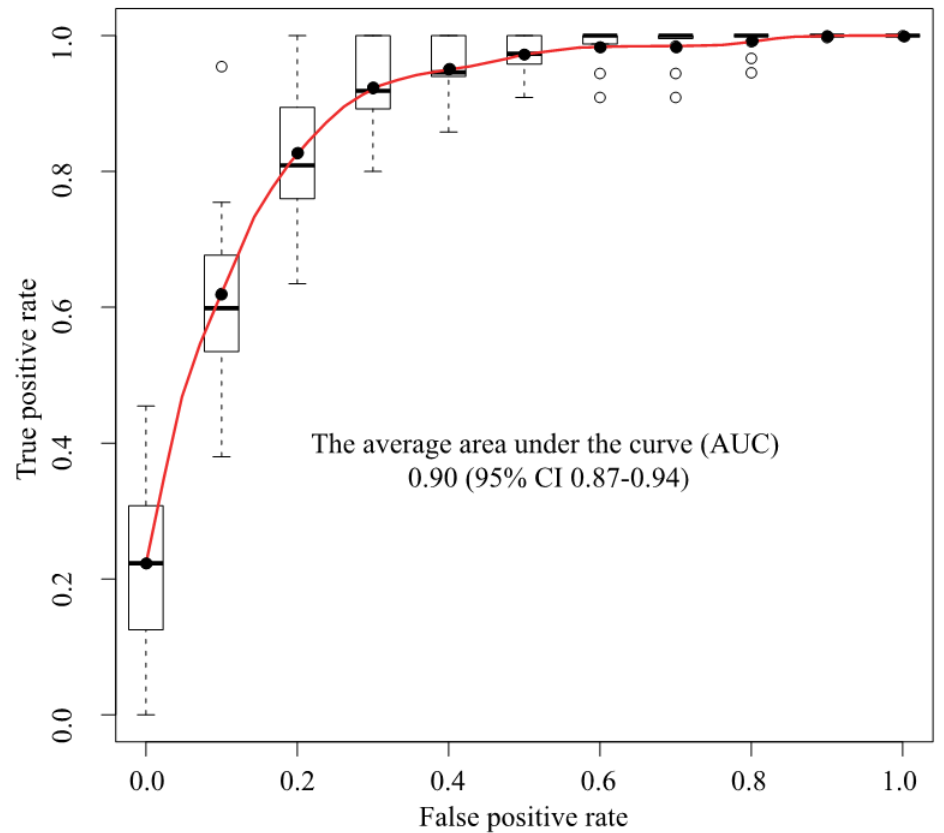
Figure 3. ROC analysis. The average AUC was 0.90 (95% CI 0.87–0.94). ROC = Receiver operating characteristics, AUC = Area under the curve, CI = Confidence interval, Black circle = Average, White circle = Out of range value, Black solid line = Median, Box = Interquartile range, Dashed line = Range, Upper black line = Maximum value, Bottom black line = Minimum